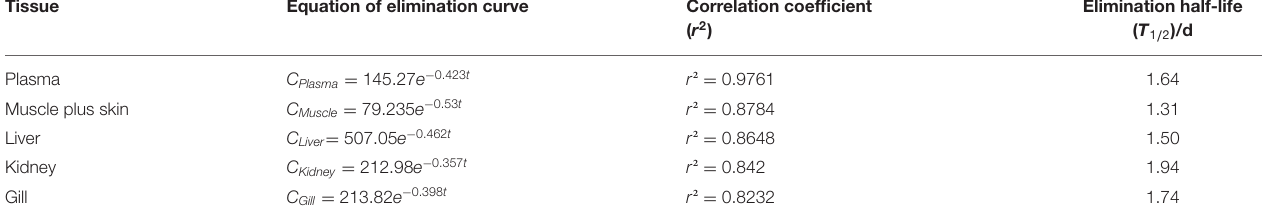
TABLE 4C | The equation of elimination curve, correlation coefficient ( r 2 ) and elimination half-life ( T 1 / 2 ) of Nile tilapia after daily oral administration of a single dose of 20 mg/kg for 5 days at 30 ◦ C. Tissue